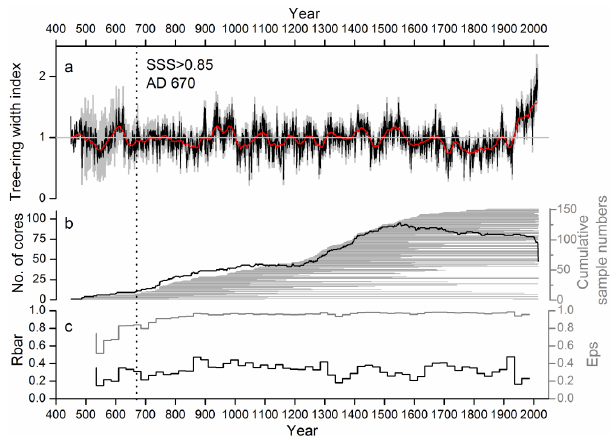
Fig. 3 a. Ring-width chronology (HY), the red line indicates the 31-year running mean, the grey 2 Figure 3. (a) Ring-width chronology (HY), the red line indicates area indicates the 2-standard errors of the ring-width chronology. b. Changing sample size over 3 the 31-year running mean, the grey area indicates the 2-standard er- time (dark line) and cumulative sample numbers. c. EPS and Rbar values. The dotted vertical line 4 rors of the ring-width chronology. (b) Changing sample size over denotes the year AD 670, when the SSS value exceeded the threshold of 0.85(SSS means the 5 subsample signal strength). 6 time (dark line) and cumulative sample numbers. (c) EPS and R bar 7 values. The dotted vertical line denotes the year AD 670, when the SSS value exceeded the threshold of 0.85 (SSS means the subsam- ple signal